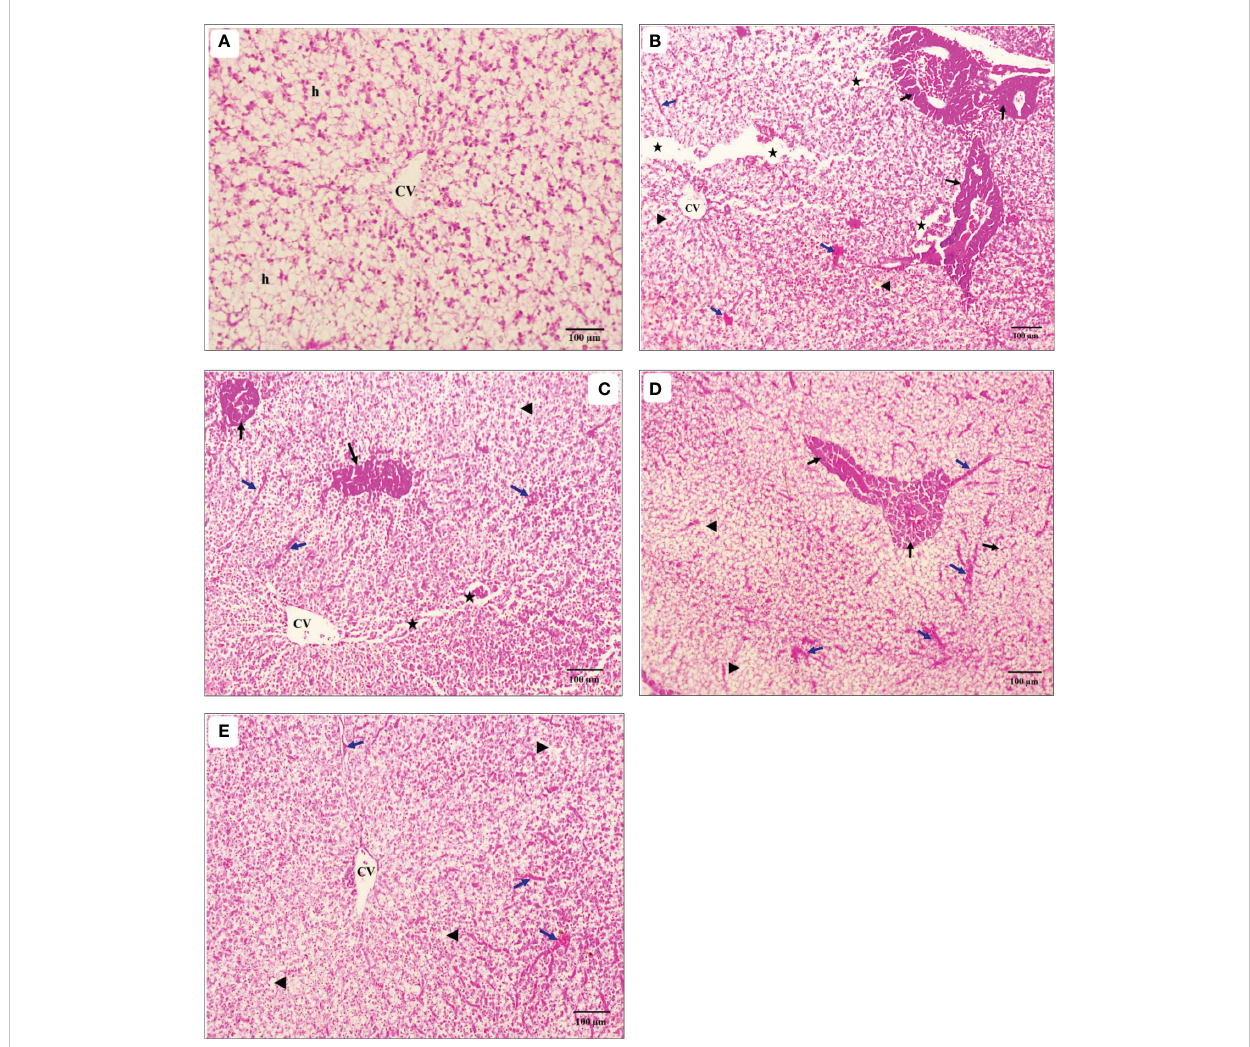
FIGURE 5 Light micrograph of the liver transverse sections of hybrid red tilapia fed different ratios of corn oil (CO): Aquafat-O ® (AQ-O) and exposed to cold stress. (A) the negative treatment (T 0- ), (B) the positive treatment (T 0+ ), (C) T 1 (2 CO: 1 AQ-O), (D) T 2 (1 CO: 2 AQ-O), and (E) T 3 (3 CO: 0 AQ-O) (×100; bar = 100µm; H & E stains). h: hepatocytes; CV: the central vein (black arrows); necrosis: (arrowheads); degeneration (stars); in fi ltration and hemolysis (blue arrows) of the